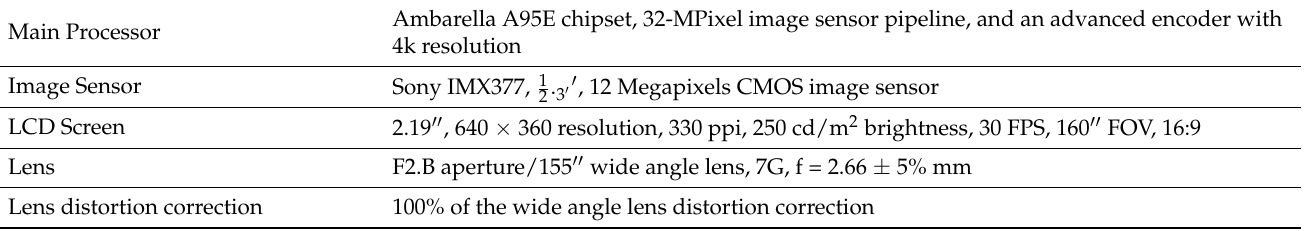
Table 1. Specifications of the Yi 4k action camera used. Table 1. Speci fi cations of the Yi 4k action camera used.